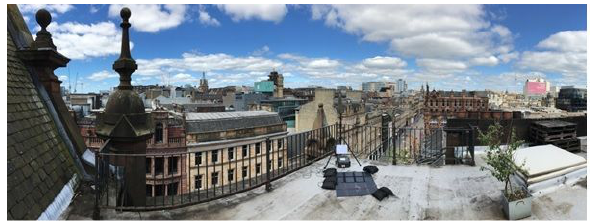
Figure 1: Glasgow City Centre monitoring